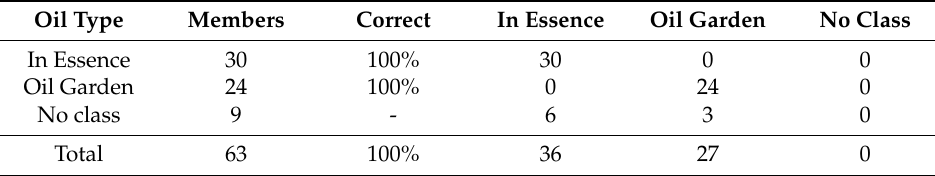
Table 4. Misclassification analysis of the analyzed lavender oil samples by